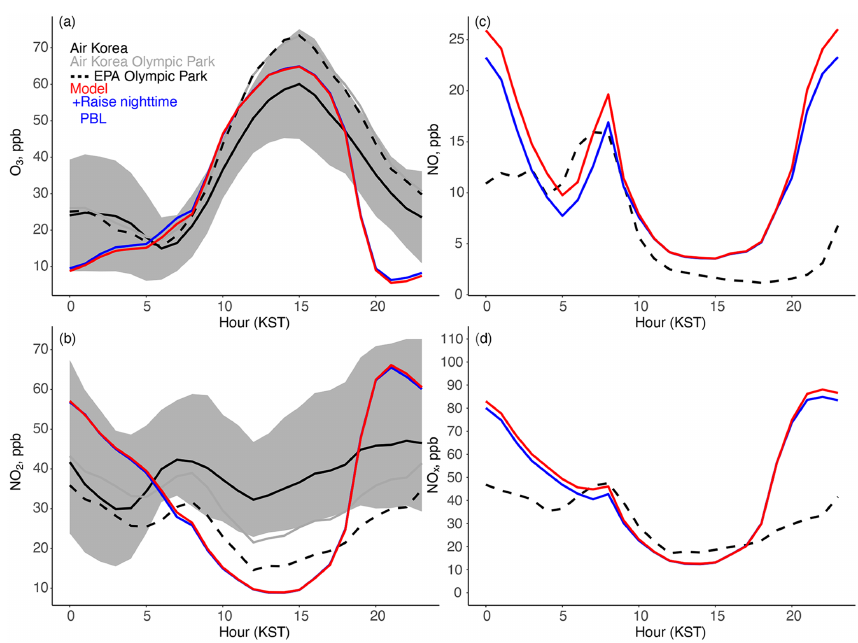
Figure 9. Mean diurnal cycle from 1 May to 7 June 2016 for (a) ozone and (b) NO 2 for the AirKorea sites within the GEOS-Chem grid box (Fig. 1b) and for (c) NO and (d) NO x at Olympic Park. The gray shading represents the standard deviation across the AirKorea sites. The solid gray line is the AirKorea site closest to Olympic Park, and the dashed line is the measurement from the EPA (Table 2) at Olympic Park. The sensitivity study (blue line) is described in Sect. 5.3.